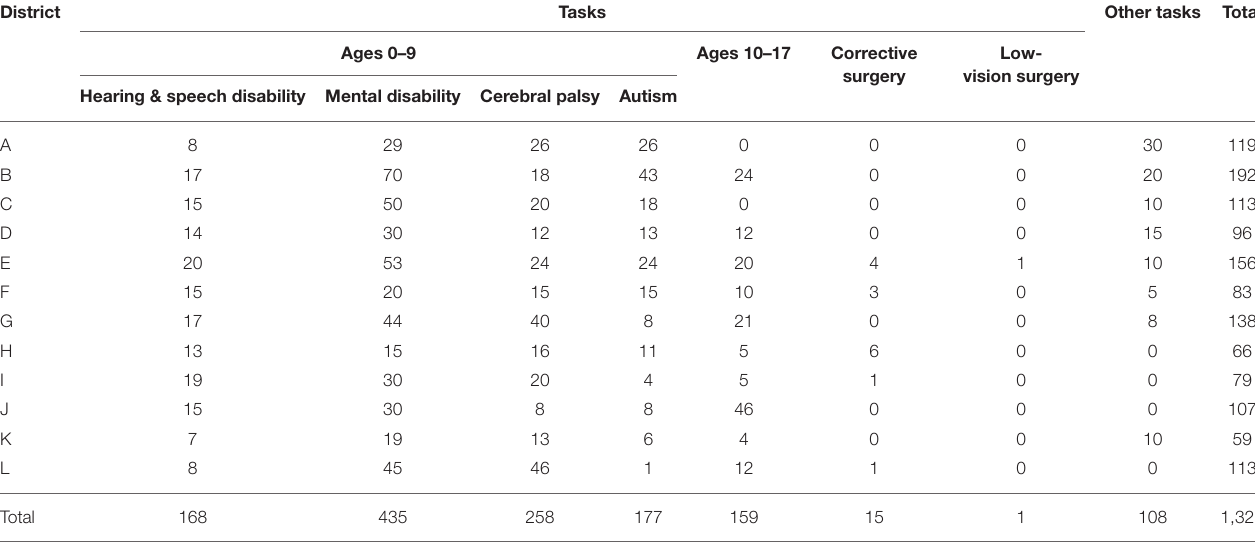
TABLE 4 | Allocation of rehabilitation assistance tasks for children with disabilities in City J (2018). District Tasks Other tasks Total Ages 0–9 Ages